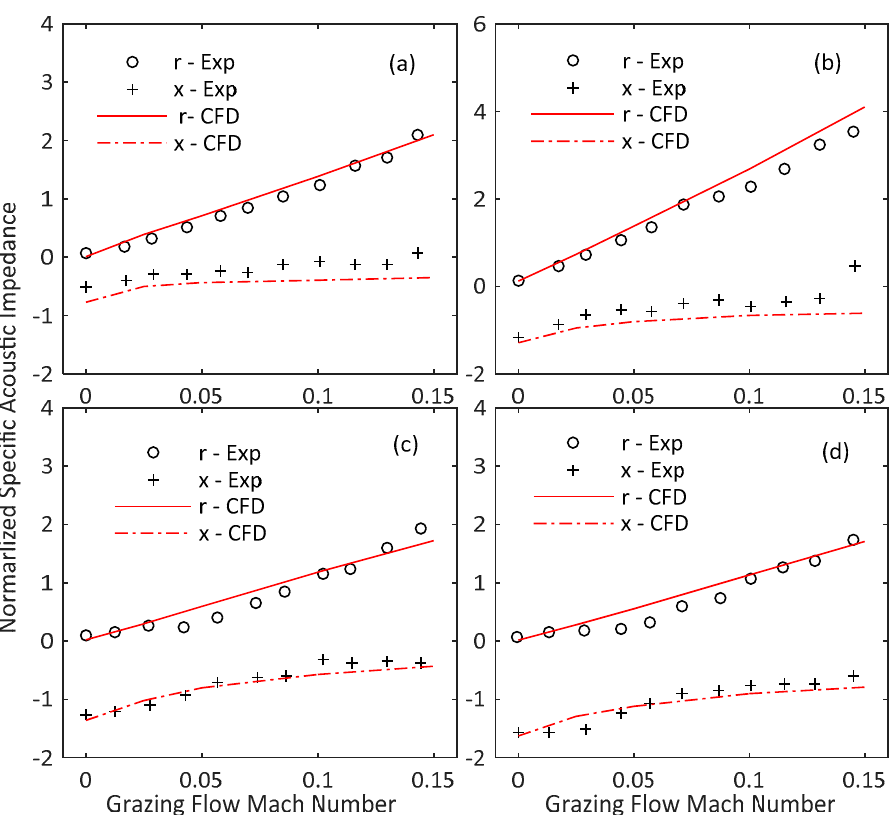
Figure 11. Numerical and experimental comparison of normalized specific acoustic impedance as a function of the grazing flow Mach number for ( a ) liner JG1, ( b ) liner JG2, ( c ) liner JG3 and ( d ) liner JG4 [23].